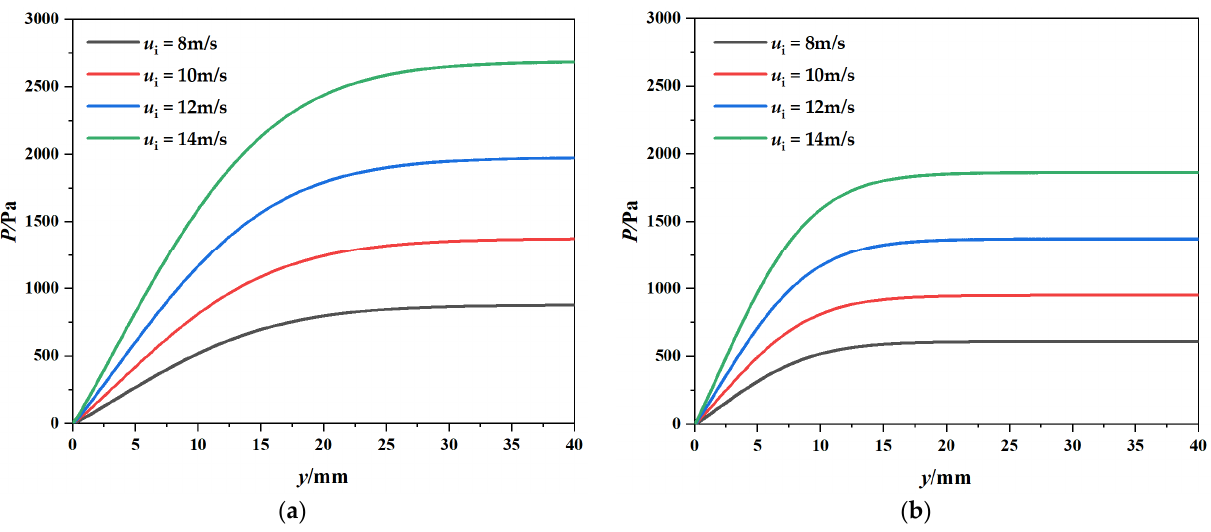
Figure 5. Velocity distribution with different u i over logarithmic spiral wall surfaces at ( a ) x / R = 1 and ( b ) x / R = 2/3.